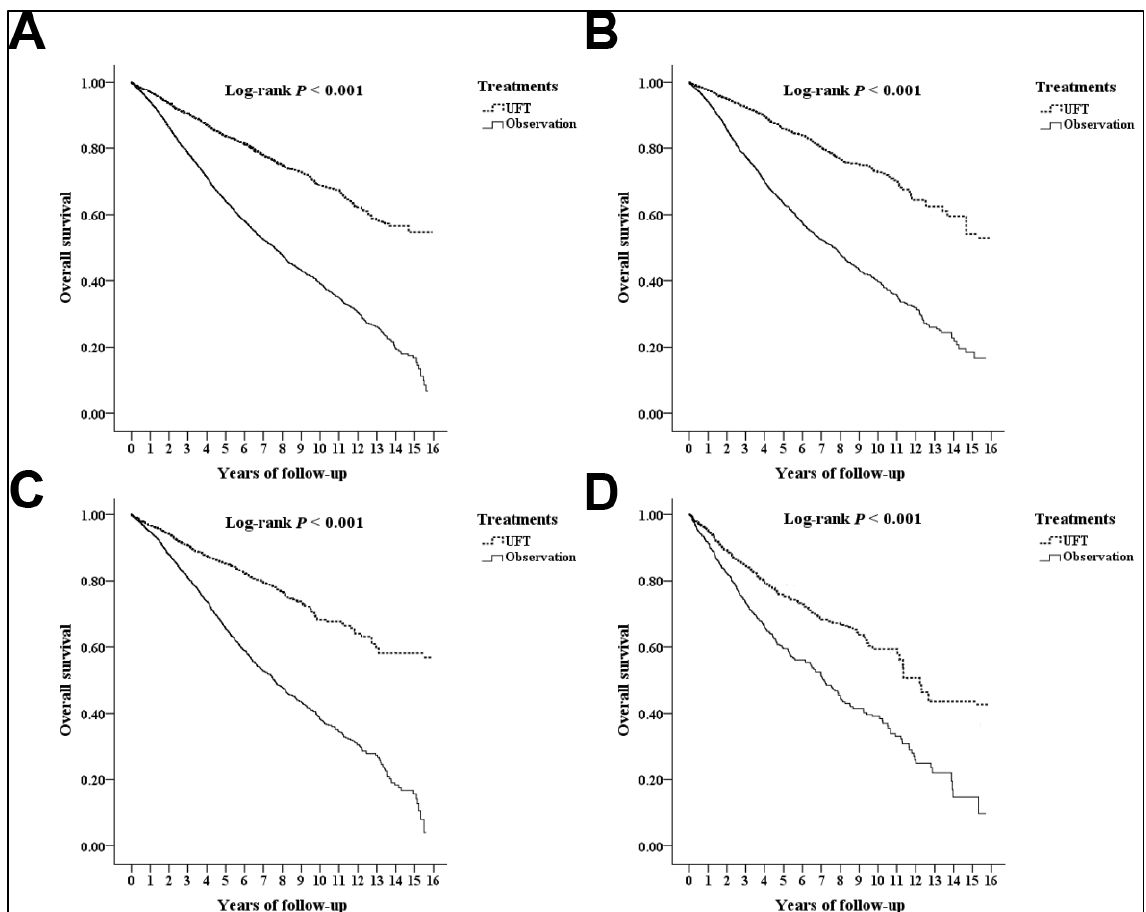
Figure 3. Kaplan – Meier plots for the cumulative risk in overall survival: overall populations ( A ); Stage IIA ( B ); Stage IIB ( C ); Stage IIC ( D ). The multivariate Cox regression model indicated that the OS did not differ significantly between the UFT and observation groups (adjusted HR 0.894; 95% CI 0.542 – 1.186; p = 0.477; Table 2). Male sex, older age, having comorbidities (i.e., HTN, DM, CKD, IHD, CHD, and stroke), and the influ- ence of the CCI_R score were significant factors with shorter OS. Table 2. Cox regression analysis of disease-free survival and overall survival.